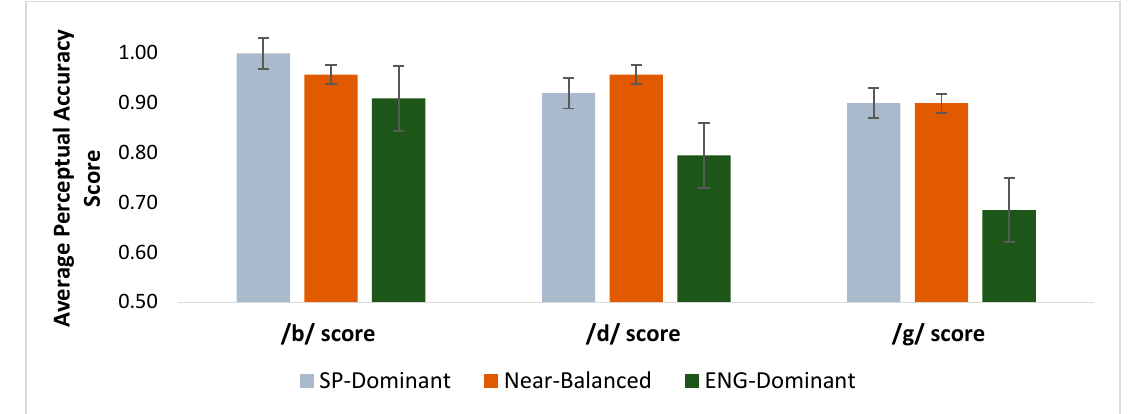
Figure 3. Average target contrast score per dominance group.